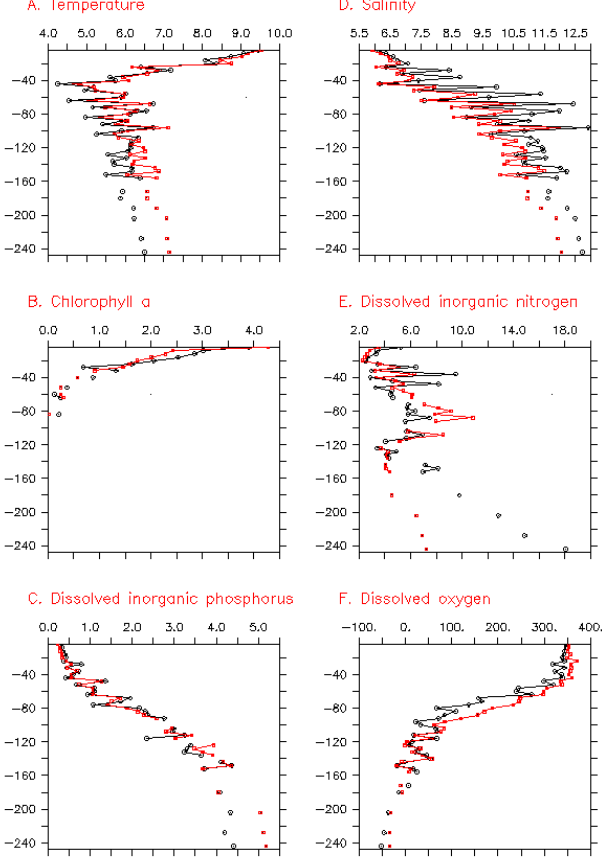
Fig. 15. Overall pattern of vertical profile. Notations same as in Fig.